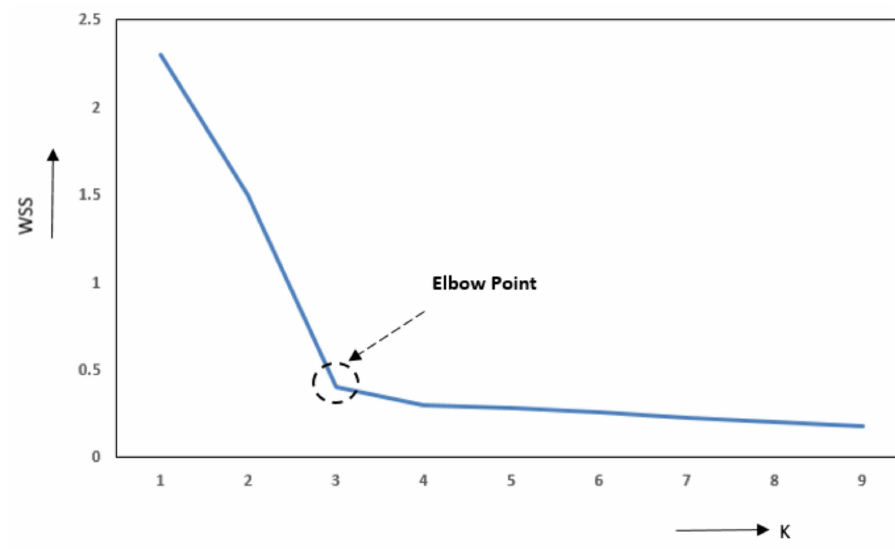
Figure 3. The evolution of the WSS vs. the number of clusters (K), indicating with an arrow the optimal point of change (Elbow Point) in the value of K = 3.